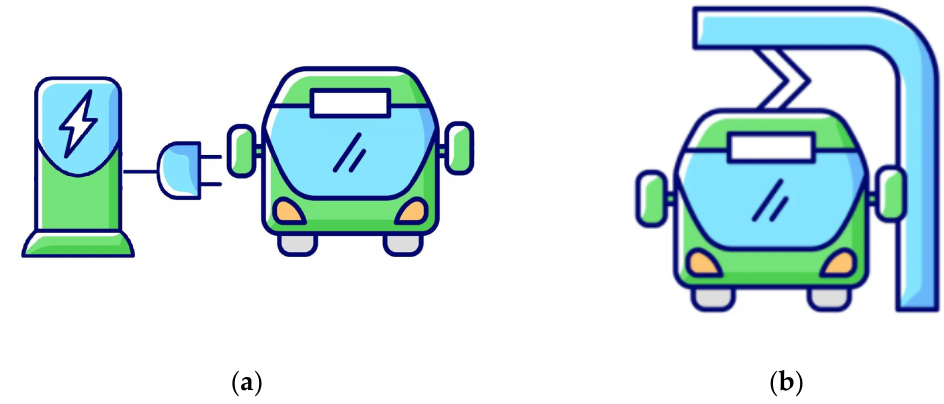
Figure 14. Representation of ( a ) depot and ( b ) opportunity charging systems.